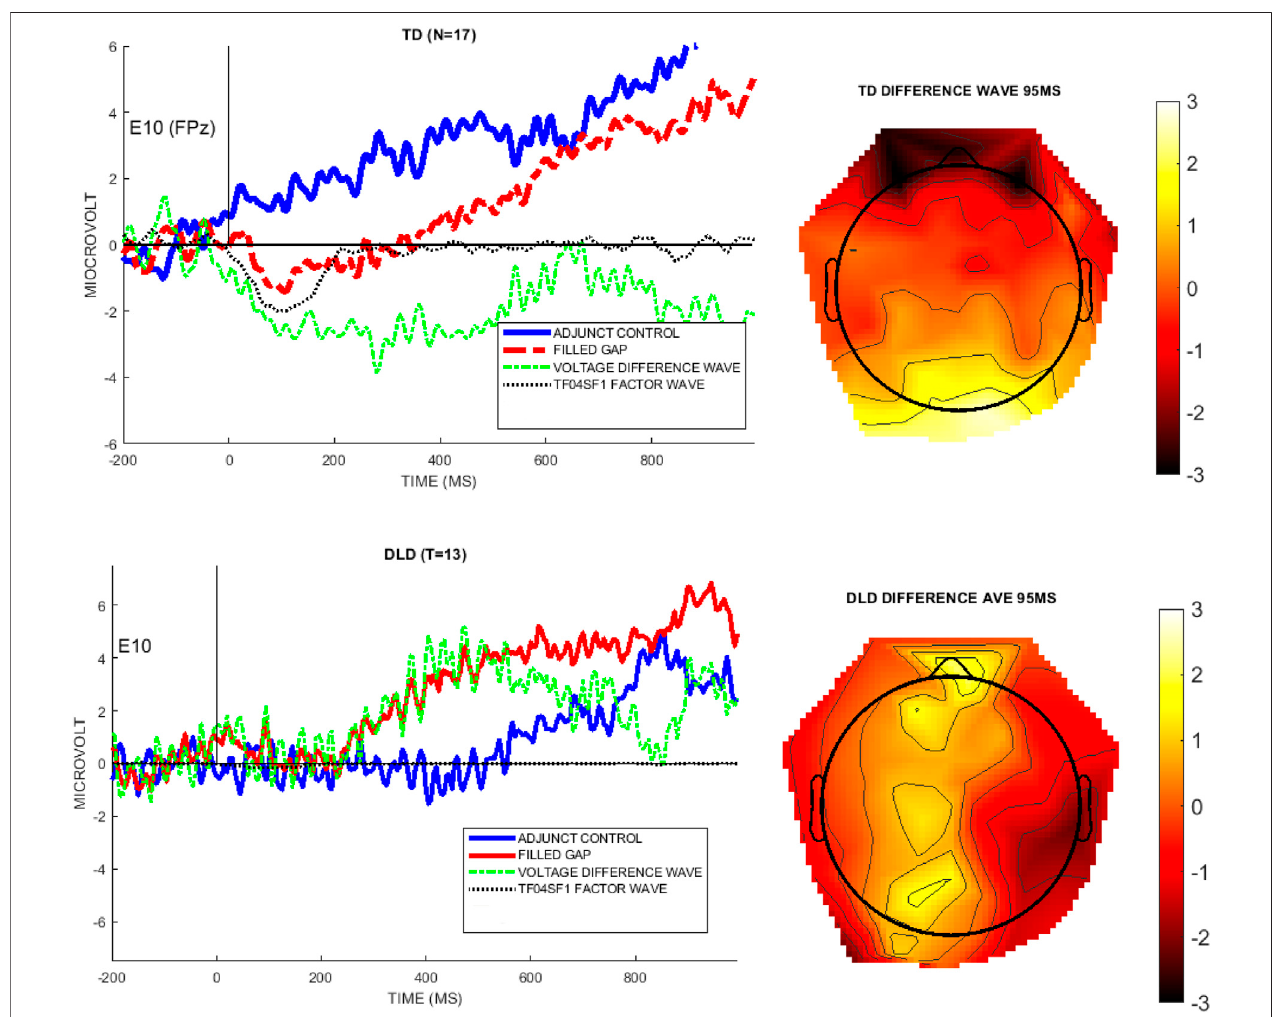
FIGURE7| TheleftgraphsshowthevoltageforeachgroupatthechannelwiththehighestweightingfortheEANcomponentTF04SF1(E10/FPz).Therightimages are topographical plots of the raw voltage difference between the Adjunct and Filled gap conditions at the peak latency of TF04 (95 ms), for each group.